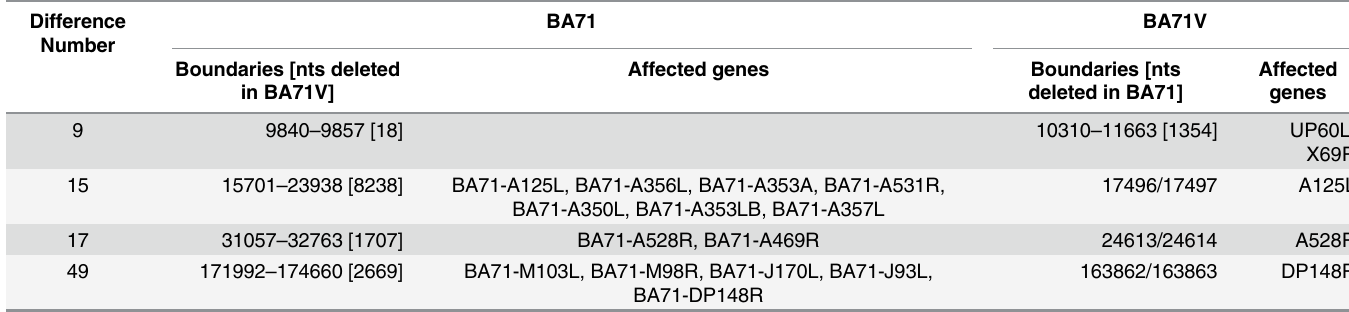
Table 2. Differences between BA71 and BA71V: Large deletions/insertions.